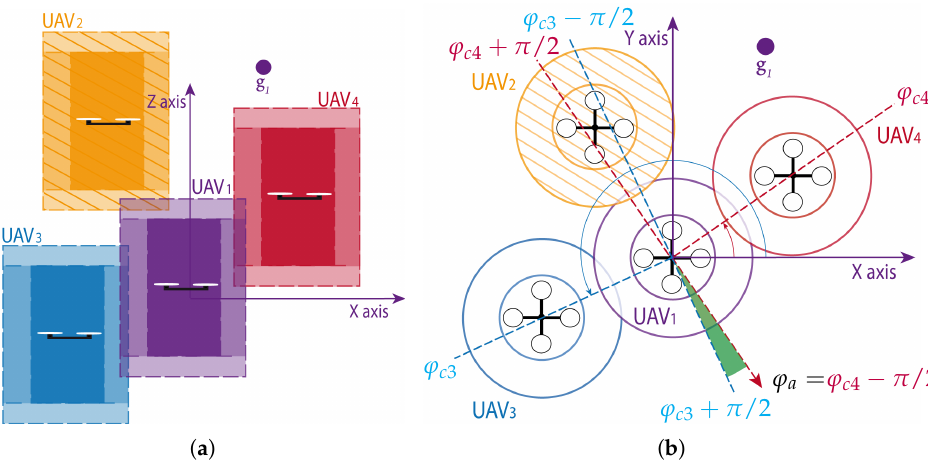
Figure 1. Example situation with several UAVs in conflict. The figure shows the avoidance maneuver computed by 3D-SWAP for UAV 1 while trying to reach its goal g 1 . All UAVs are represented with their collision, reserved and blocking cylinders. On the left ( a ), a lateral view of the scene to depict z-conflict with UAV 2. On the right ( b ), a view from above to show xy-conflicts with UAV 3 and 4, and the computation of the avoidance direction.